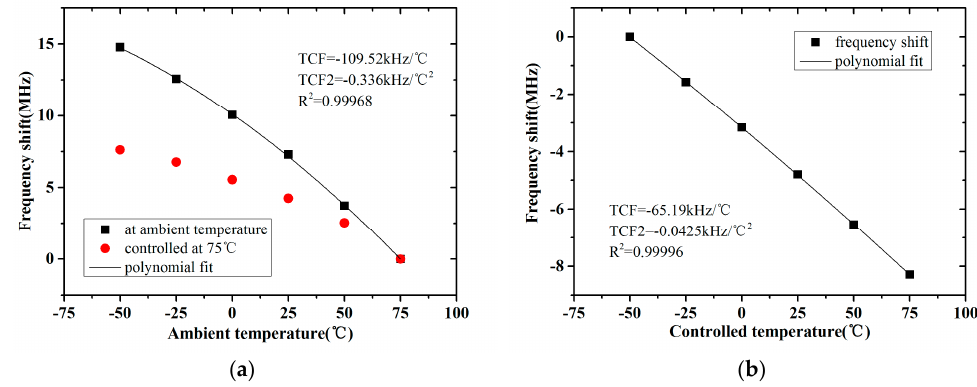
Figure 11. The response of the sensor sample to temperature: ( a ) one with different ambient temperatures; ( b ) one with resonator controlled at different temperatures. temperatures; ( b ) one with resonator controlled at different